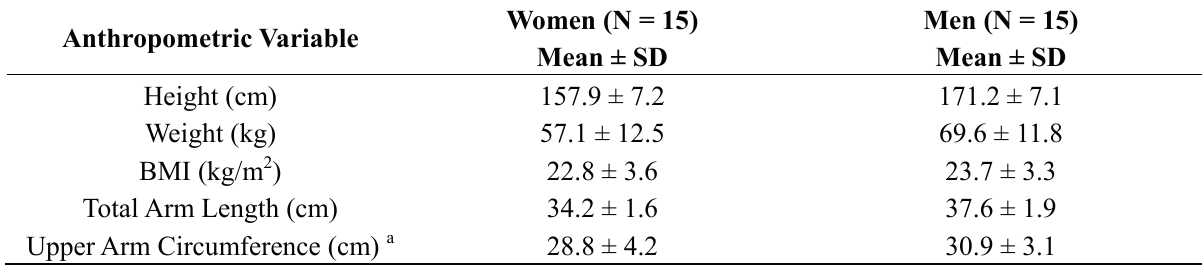
Table 4. Anthropometric variables: descriptive